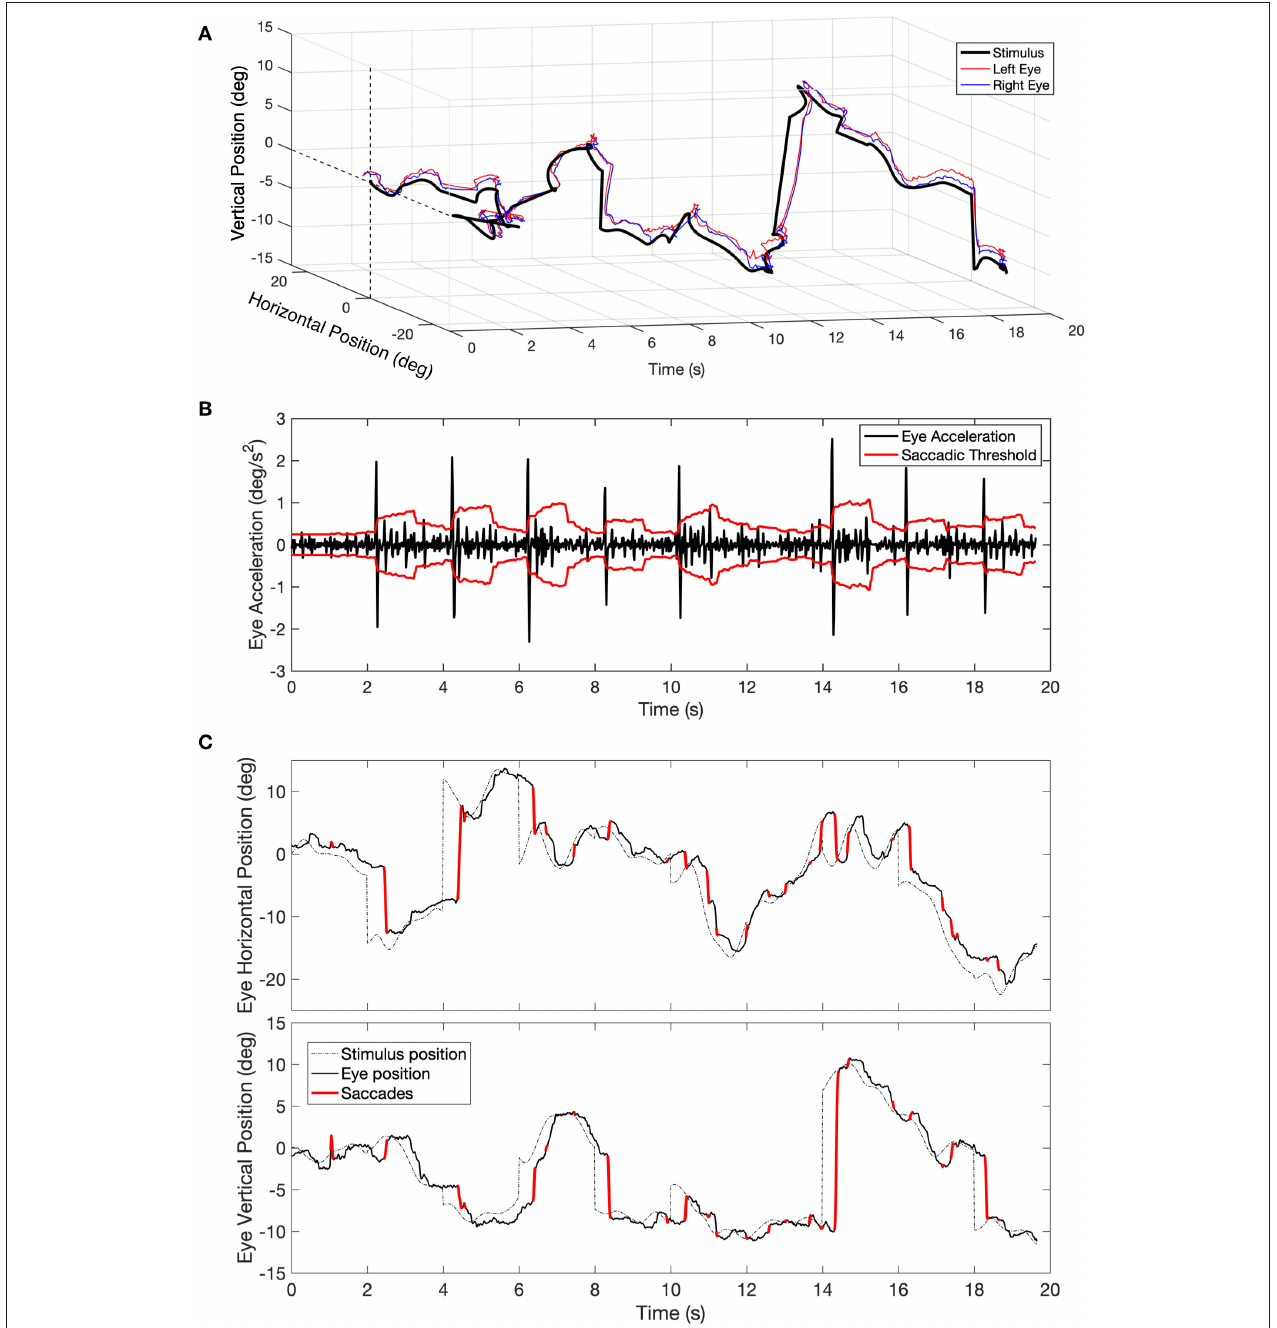
FIGURE 1 | (A) Example of a time series of eye movements’ positions recorded during a trial of 20s of the tracking task. (B) Example of eye acceleration and the value of the adaptive saccadic threshold for one eye plotted as a function of time. The adaptive threshold (in red) at any given time point is computed as the standard deviation of acceleration distribution in the preceding 60 samples, multiplied by a constant ( K = 3.4). Whenever acceleration exceeds the momentary threshold, the time point is marked as being part of a saccade. (C) Back-projection of the time points marked as being part of a saccade onto the original time series of eye positions (top figure showing the horizontal and the bottom figure showing the vertical component).